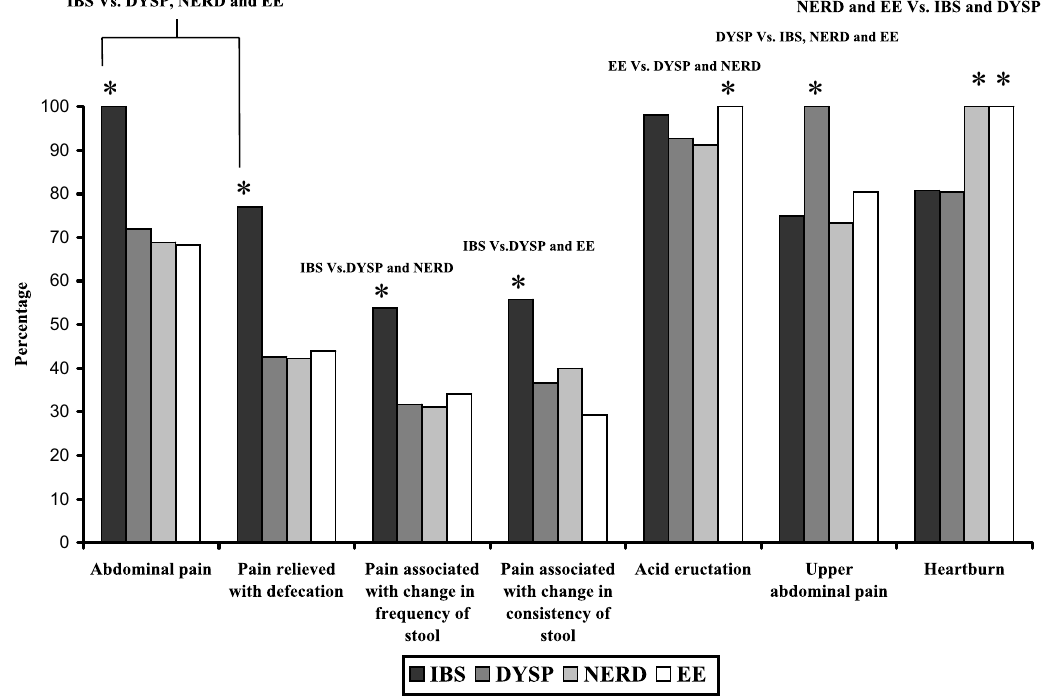
Fig. 2 – The prevalence of statistically significant upper and lower gastrointestinal symptoms in patients with irritable bowel syndrome (IBS), dyspepsia (DYSP), non-erosive reflux disease (NERD) and erosive esophagitis (EE). The figure depicts the percentage of patients having individual symptoms in each group. ∗ = P <